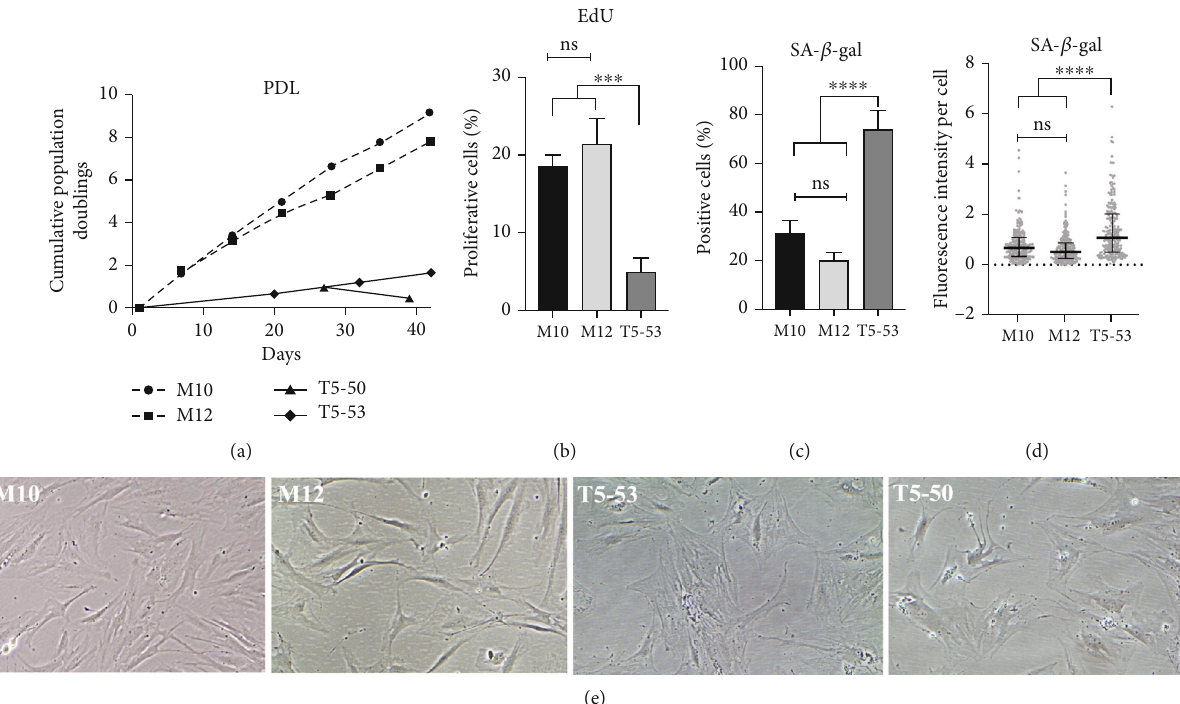
Figure 2: Characterization of human MSC cell cultures. (a) Cumulative population doublings during cellular expansion ex vivo. Passage interval of samples: M10: P5 to P10; M12: P7 to P12; T5-50: P6 to P8; T5-53: P7 to P10. (b) Percentage of proliferative cells. One-Way ANOVA and Tukey ’ s multiple comparisons test. (c) Percentage of cells with SA- β -galactosidase activity; 100 cells analyzed per well. One-Way ANOVA and Tukey ’ s multiple comparisons test. (d) Intensity of SA- β -galactosidase activity per cell; cell fl uorescence intensity (CF) calculated with ImageJ by CF = totalfluorescence – ð cell area × background intensity Þ . Kruskal-Wallis and Dunn ’ s